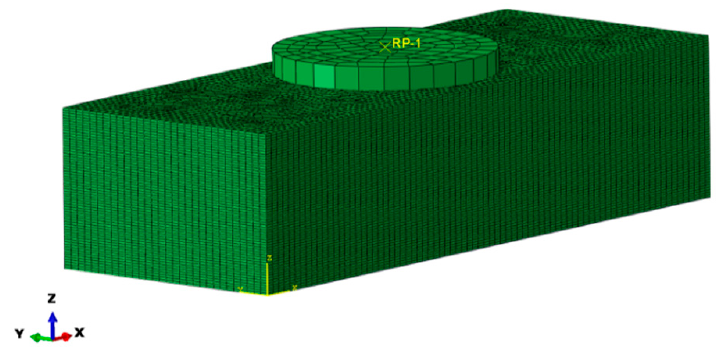
Figure 5. Finite element model of composite laminate assembly.